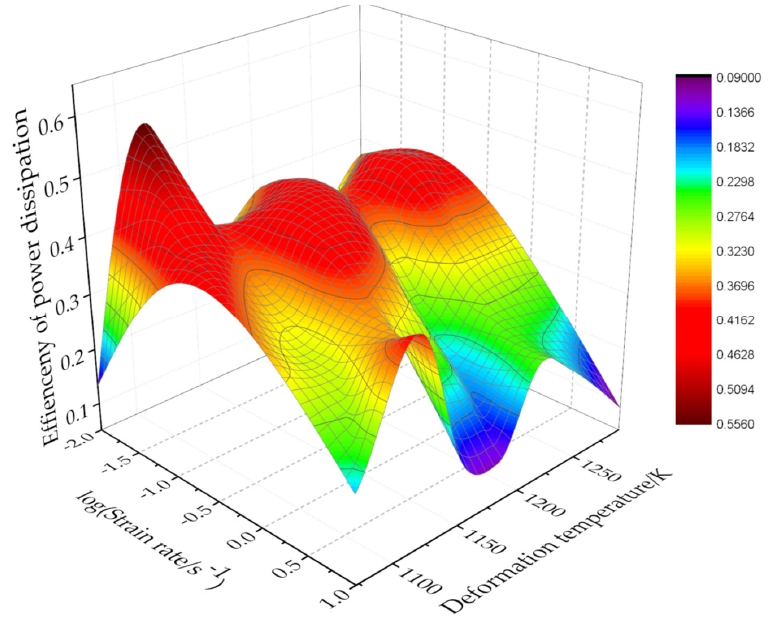
Figure 12. Map of the power dissipation efficiency of the isothermal compression of the Ti–3.3Al– 1.5Zr–1.2Mo–0.6Ni alloy.